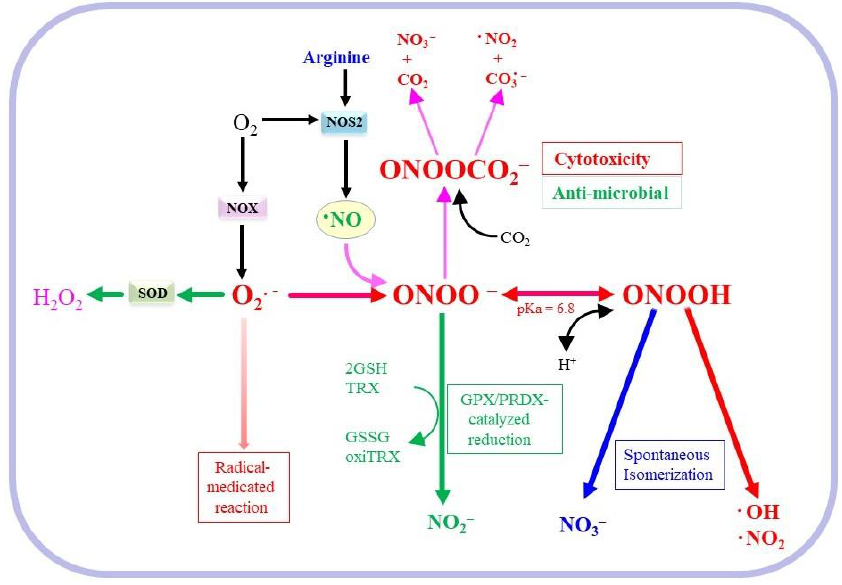
Figure 2. Conversion of •NO and ONOO − . Activated macrophages simultaneously produce O 2 •